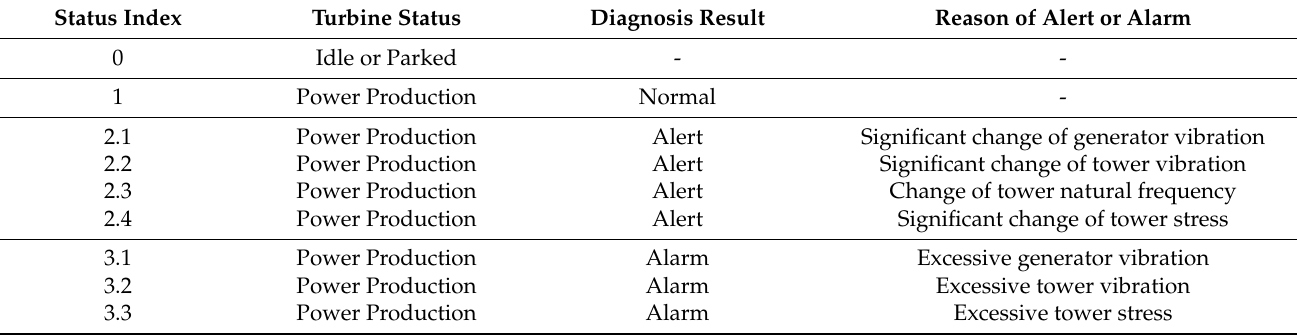
Table 3. Description of turbine status